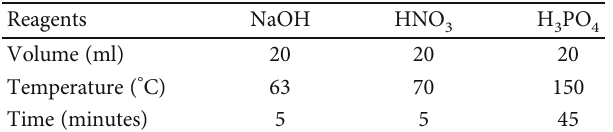
Table 2: Volume of reagents, temperature, and duration for treatments at each stage.